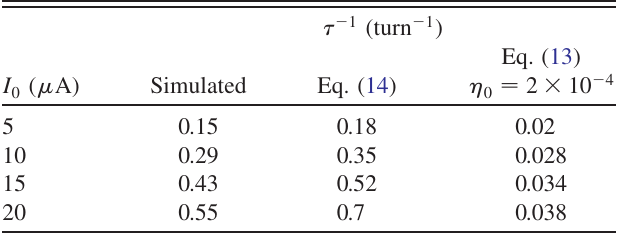
TABLE II. Amplitude growth rate of the harmonic (cid:9) ¼ 1 : 5 cm observed in simulations (second column), predicted by Eq. (14) for a ¼ 0 : 5 cm and (cid:9) ¼ 1 : 5 cm (third column), and given by the conventional microwave instability formula, Eq. (13), with the constant slip factor (cid:10) 0 ¼ þ 2 (cid:5) 10 (cid:3) 4 (fourth column). and that calculated using Eqs. (2) and (13) and the constant slip factor (cid:10) 0 ¼ 2 (cid:5) 10 (cid:3) 4 . Also, the table shows the growth rate given by Eq. (14) for a ¼ 0 : 5 cm and (cid:9) ¼ 1 : 5 cm . According to the table, Eq. (14) predict growth rates approximately 20% higher than those observed in the simulations. Below transition ( (cid:10) 0 ¼ (cid:3) 0 : 04 ), bunches with a peak current of 5 (cid:3) A exhibited no instability during 100 turns, the maximum number of simulated turns. The other three simulated cases with a peak current of 10, 15, and 20 (cid:3) A